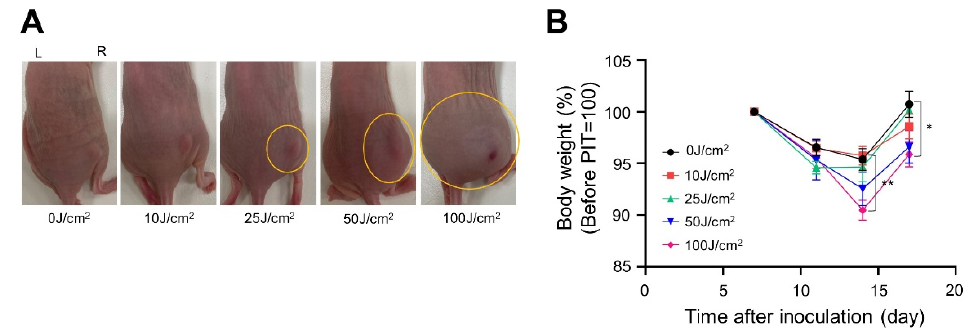
Figure 4. Side effects of the NIR-PIT with Pan-IR700 in A431-GFP-luc cells: ( A ) appearance on the treatment site 24 h after light exposure, where the yellow circles indicate the edema-affected area; ( B ) the percentage of weight change from immediately before the NIR light irradiation was measured ( n = 10; one-way ANOVA followed by Tukey’s test; *, p < 0.05 and **, p < 0.01).